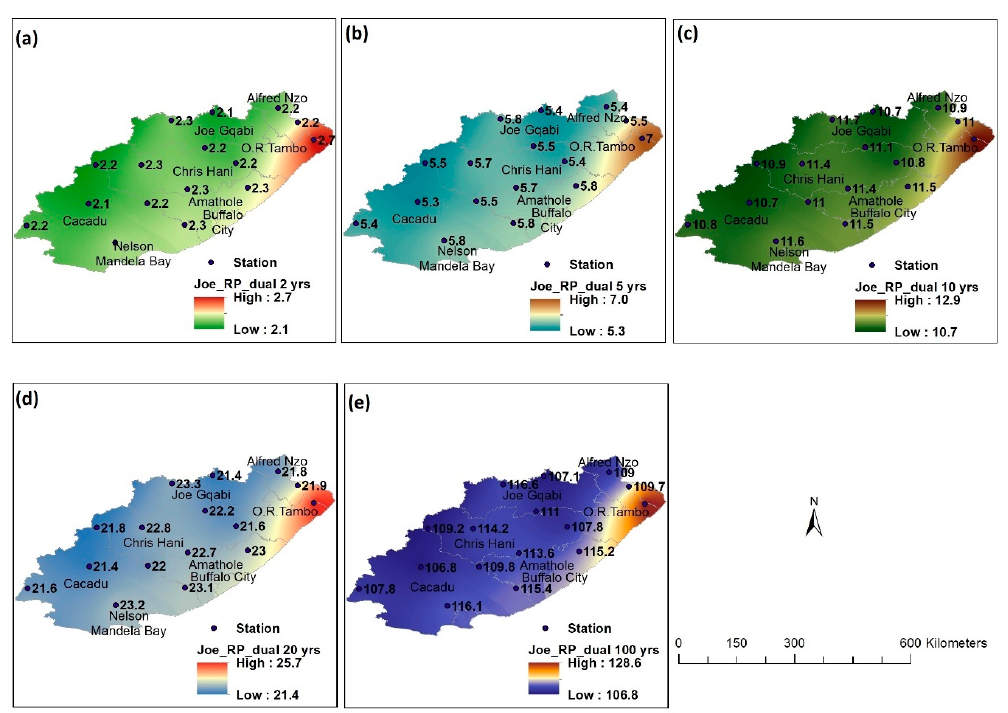
Figure 7. Spatial distribution of conjunctive return period corresponding to ( a ) 2-year, ( b ) 5-year, ( c )